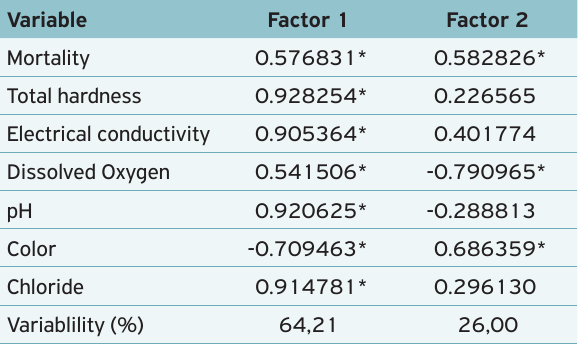
Table 4. Values of two extracted factor loadings for physical-chemical parameters and toxicity in the Atibaia River.